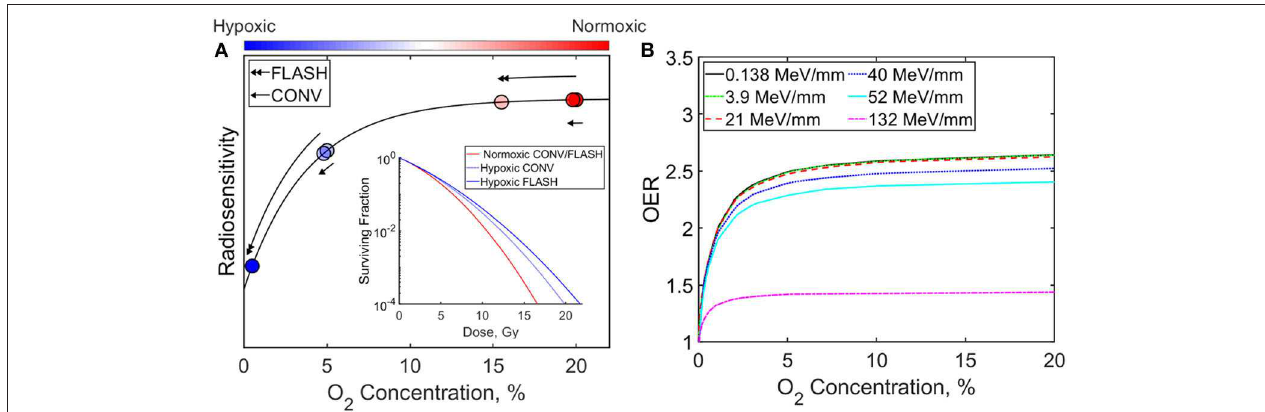
FIGURE 12 | (A) Radiosensitivity and cell surviving fraction dependency on oxygen concentration for FLASH and conventional (CONV) radiation therapy. Models are from Pratx et al. and Adrien et al. for normoxic (20% oxygen concentration) and hypoxic (5% oxygen concentration) cells. (B) Oxygen enhancement ratio with O 2 concentration for irradiation with different LET [38,